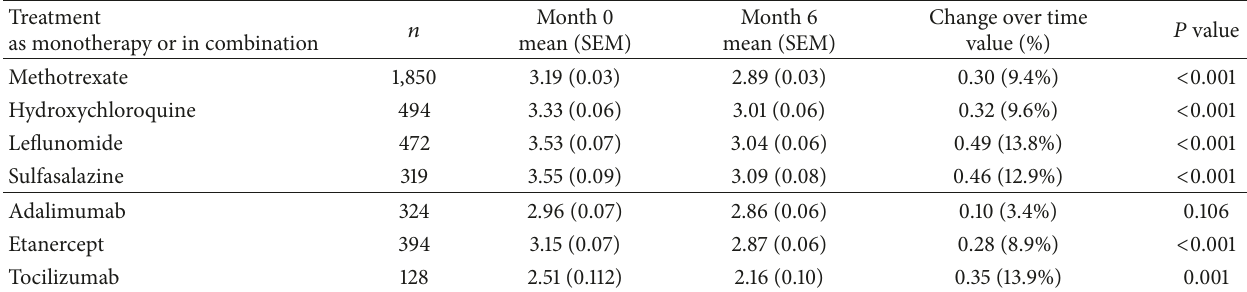
Table 3: Change in DAS28-ESR scores over a 6-month period.